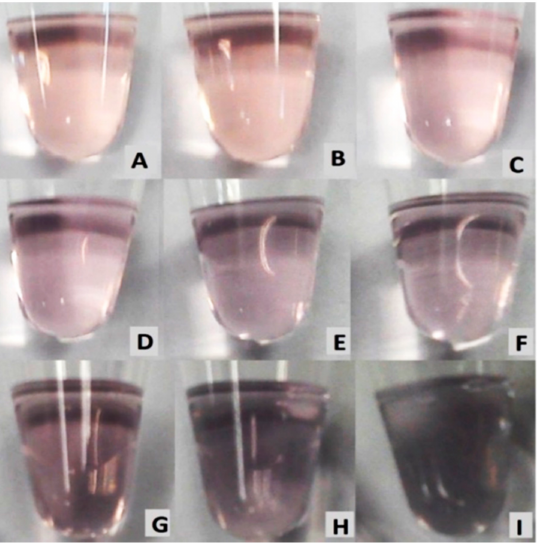
Figure 7. Visual color change of ( A ) AuNPs, and AuNPs in the presence of the following different concentrations of melamine: ( B ) 1 × 10 − 9 M, ( C ) 1 × 10 − 8 M, ( D ) 1 × 10 − 7 M, ( E ) 1 × 10 − 6 M, ( F ) 1 × 10 − 5 M, ( G ) 1 × 10 − 4 M, ( H ) 1 × 10 − 3 M, and ( I ) 1 × 10 − 2